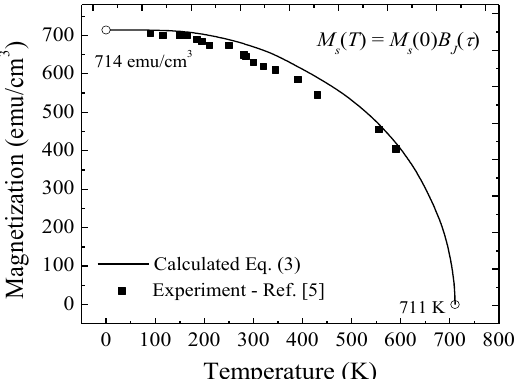
Figure 2. The calculated and experimental temperature dependence of saturation magnetization M ( T ) for LTP MnBi. s